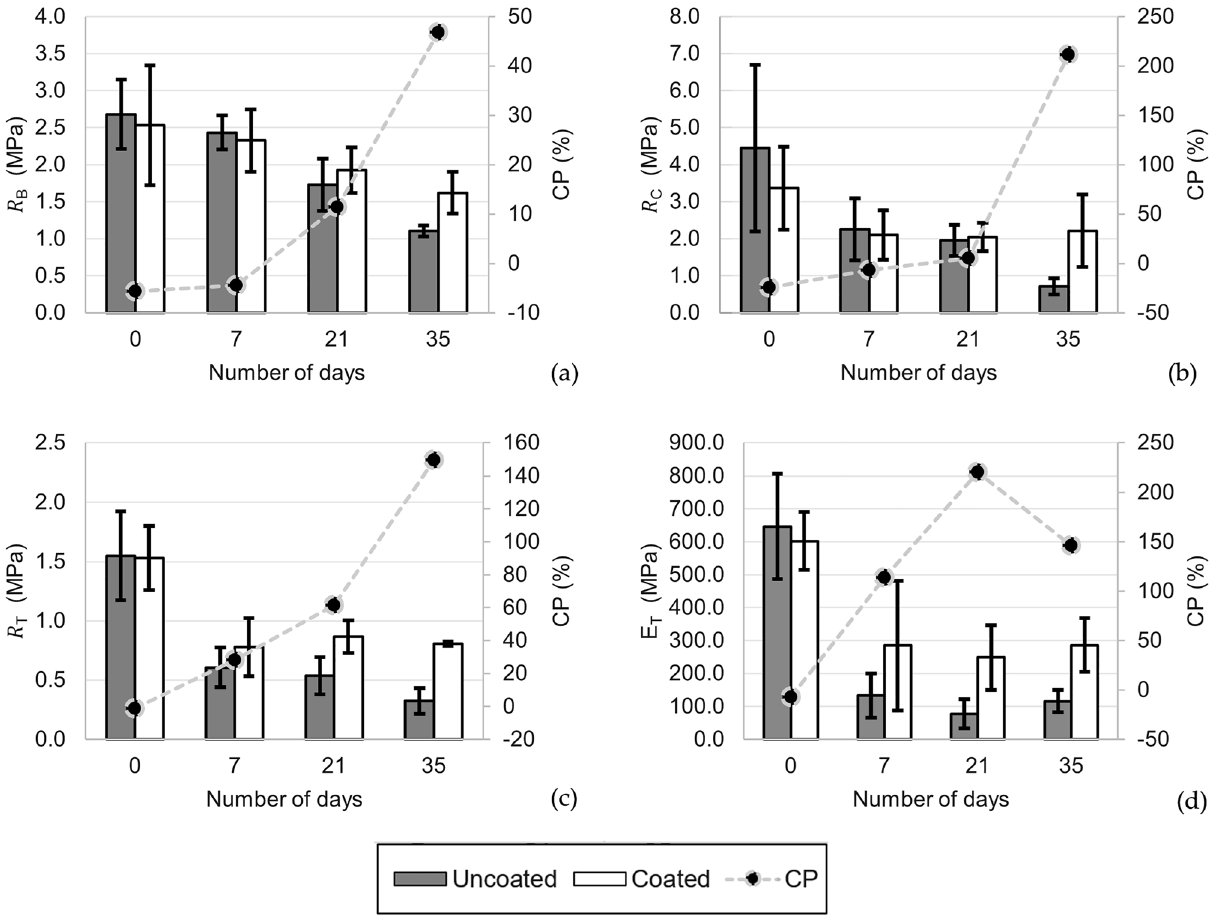
Figure 2. Mechanical test results: ( a ) R B and CP against the number of days exposed to weathering conditions; ( b ) R C and CP against the number of days exposed to weathering conditions; ( c ) R T and CP against the number of days exposed to weathering conditions and ( d ) ET and CP against the number of days exposed to weathering